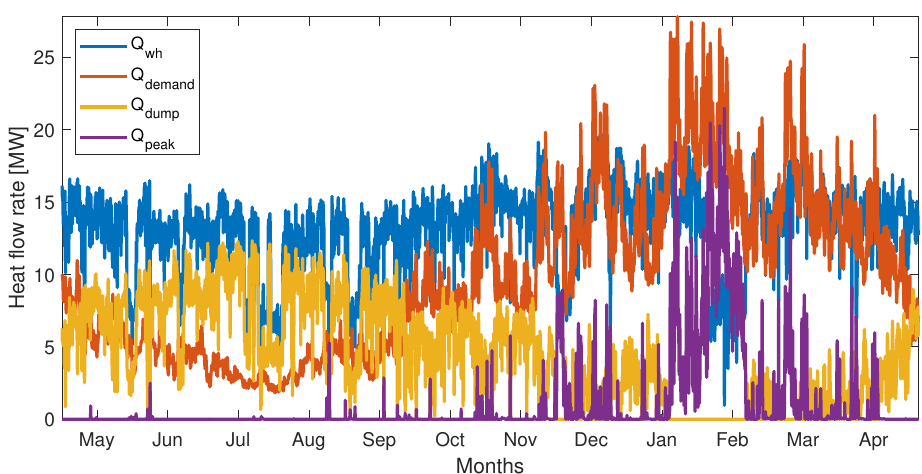
Figure 2. Data for hourly average waste heat available ( Q wh ), heat demand, peak heating and dumped heat ( Q dump ) from May 2018 to April